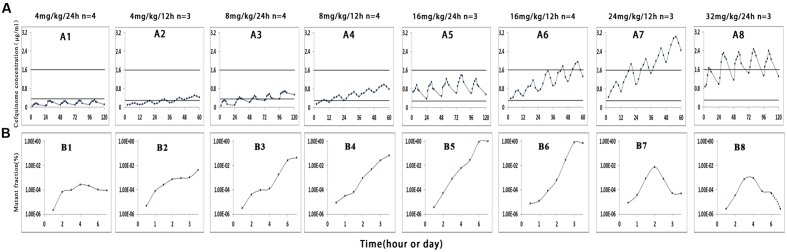
Effect of cefquinome concentration on mutant enrichment. 1, 3, 5, and 8 correspond to the four different treatment groups once daily for 5 days, 2, 4, 6, and 7 correspond to the four different treatment groups twice daily for 2.5 days, n is the animal number per group.
In vivo simulated pharmacokinetics (A) and the fraction of resistant mutant (B). Since the amount of bacteria for the group 32 mg/kg/24 h was below the minimum detection limit (200 CFU/mL) on the seventh day (Figure 2), we cannot draw the mutant fraction (shown in dotted line).